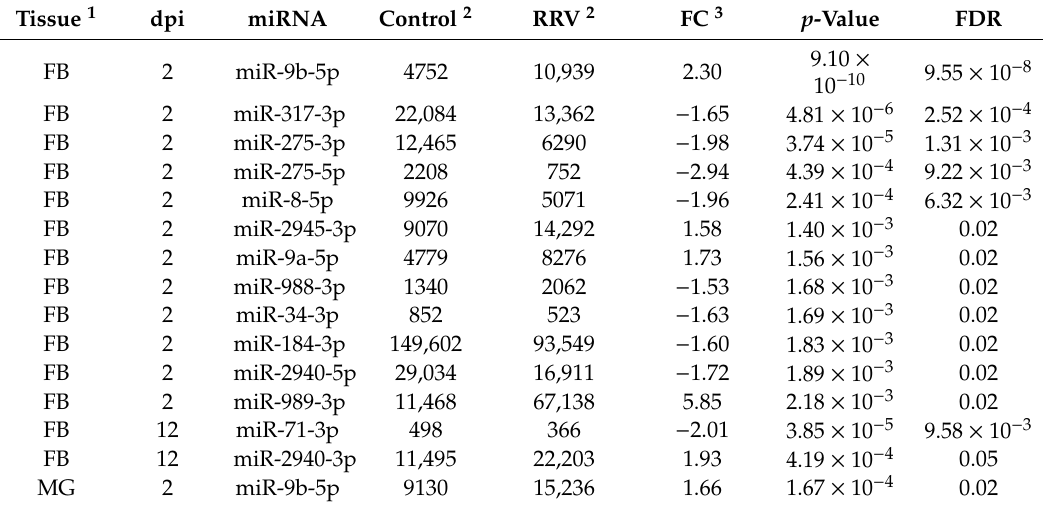
Table 1. Di ff erentially expressed Ae. aegypti miRNAs upon RRV infection. Tissue